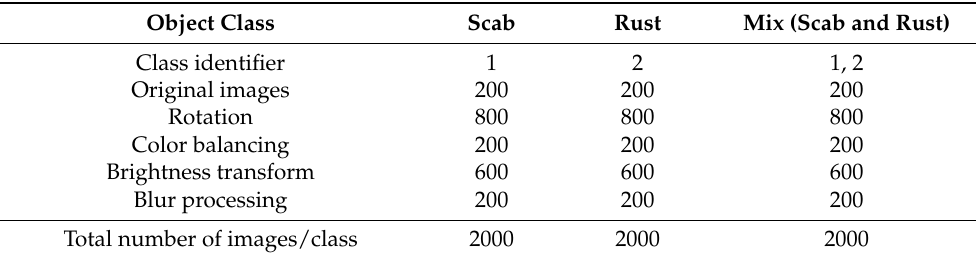
Table 1. Different diseases in apple plant and corresponding class identifier with original number of images and images produced by augmentation method for the custom dataset.